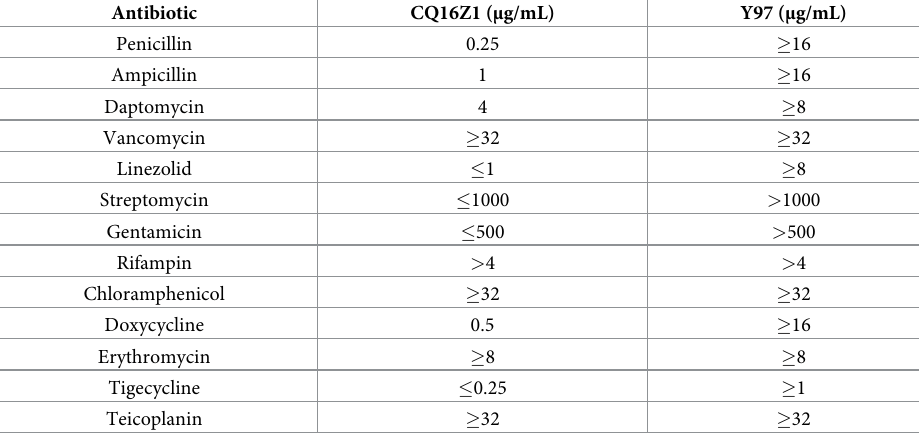
Table 2. The MIC values of CQ16Z1 and Y97. Antibiotic CQ16Z1 ( μ g/mL) Y97 ( μ g/mL) Penicillin 0.25 � 16 Ampicillin 1 � 16 Daptomycin 4 � 8 Vancomycin � 32 � 32 Linezolid � 1 � 8 Streptomycin � 1000 > 1000 Gentamicin � 500 > 500 Rifampin > 4 > 4 Chloramphenicol � 32 � 32 Doxycycline 0.5 � 16 Erythromycin � 8 � 8 Tigecycline � 0.25 � 1 Teicoplanin � 32 � 32 MIC was a range value of antibiotic